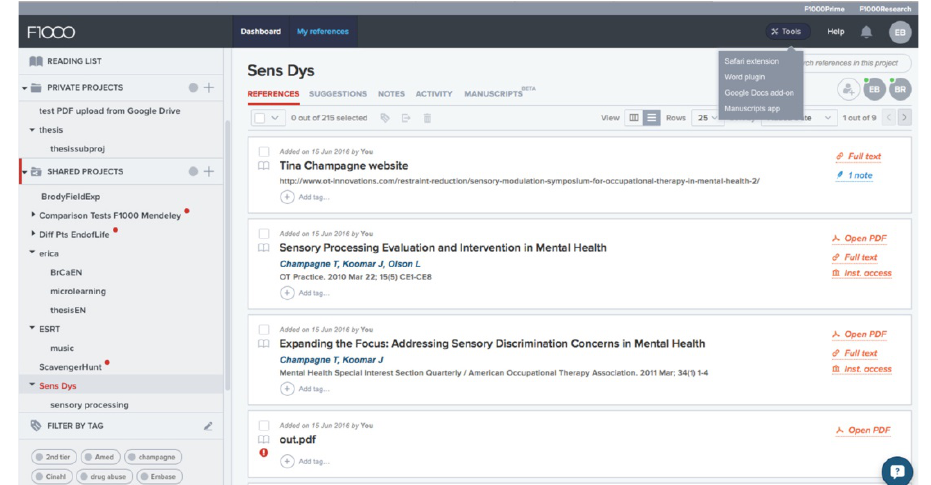
Figure 1: F1000 Workspace user